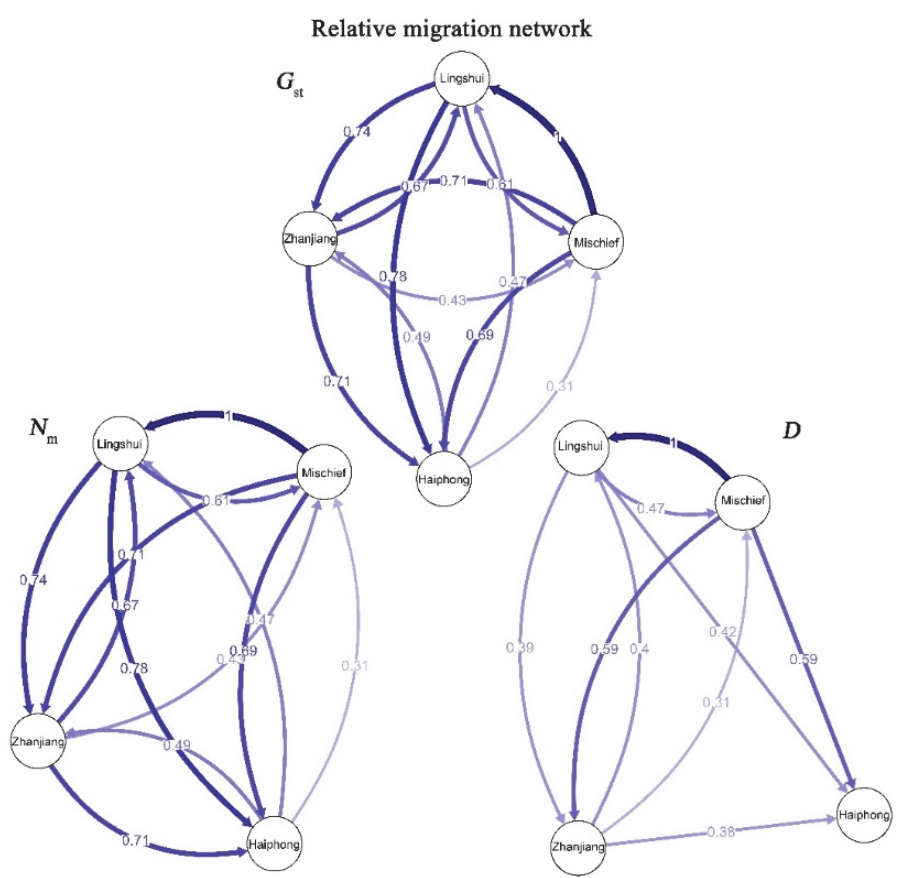
The relative migration network constructed based on divMigrate analysis indicated gene flow between the four P. fucata populations (Figure 3). High and moderate gene flow between the Mischief Reef, Zhanjiang and Lingshui populations were observed. Gene flow between Haiphong and other populations was weak. Among these populations, the Mischief Reef and Lingshui populations showed the strongest migration rates, indicating a closer relationship than between the other populations. However, no strong directionality could be detected.